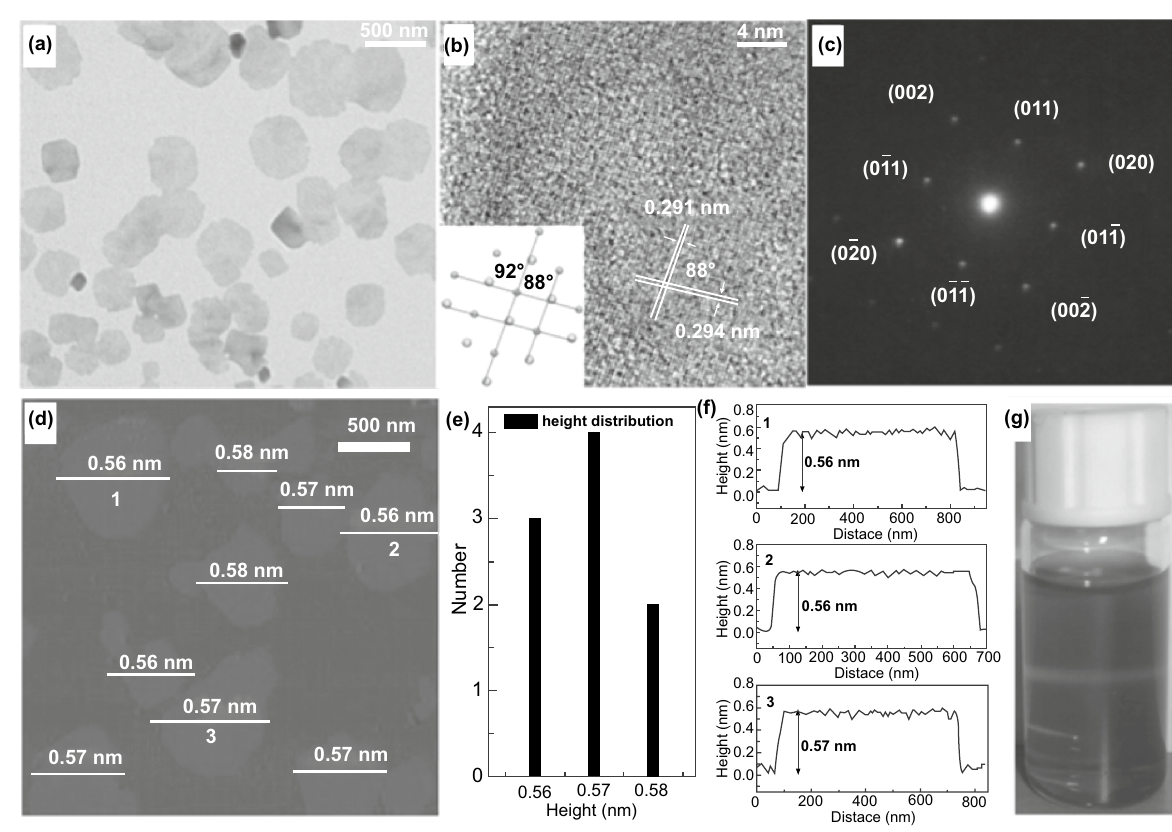
Fig. 9 a , b TEM and HR‑TEM, c selected‑area electron diffraction. d–f AFM image, height distribution, and height profiles. f (1–3) stands for 1–3 in d . g Colloidal H 2 O/ethanol (1:1) dispersion of the as‑synthesized products showing Tyndall effect. Adapted with permission from